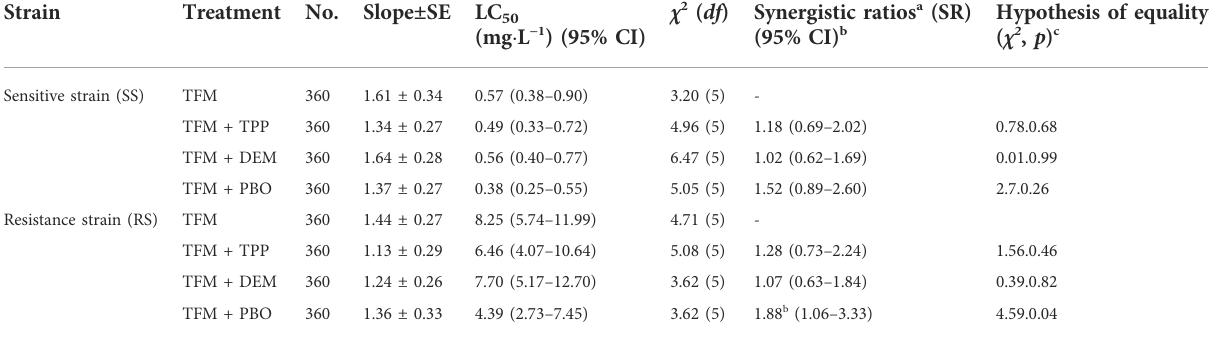
TABLE 6 Synergism of three enzyme inhibitors on TFM of SBPH.